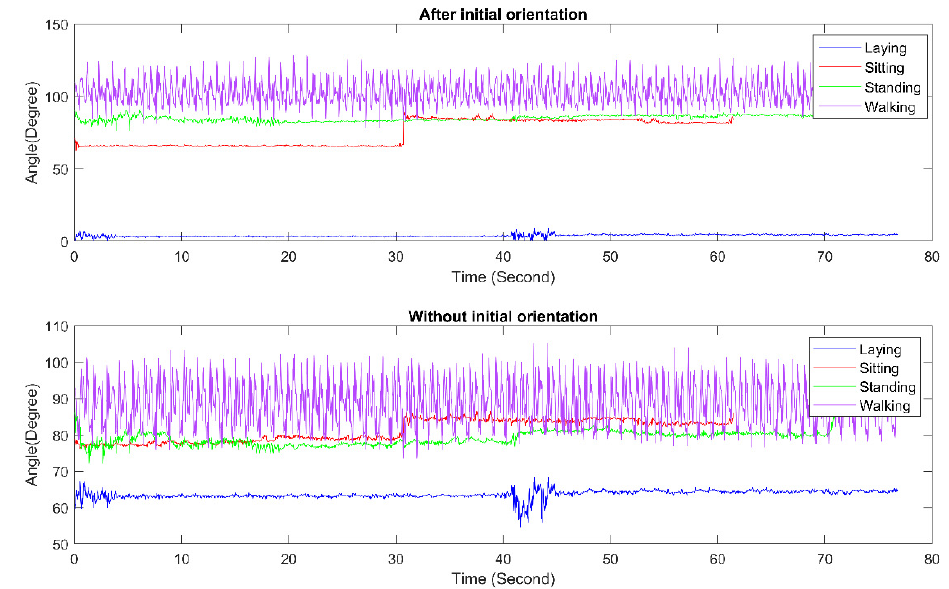
Figure 14. Plots of angle with a sudden jump in sitting angle. The up panel denotes angle of laying, sitting, standing, and walking for the HAR dataset after initial orientation and the down panel denotes angle without initial orientation.